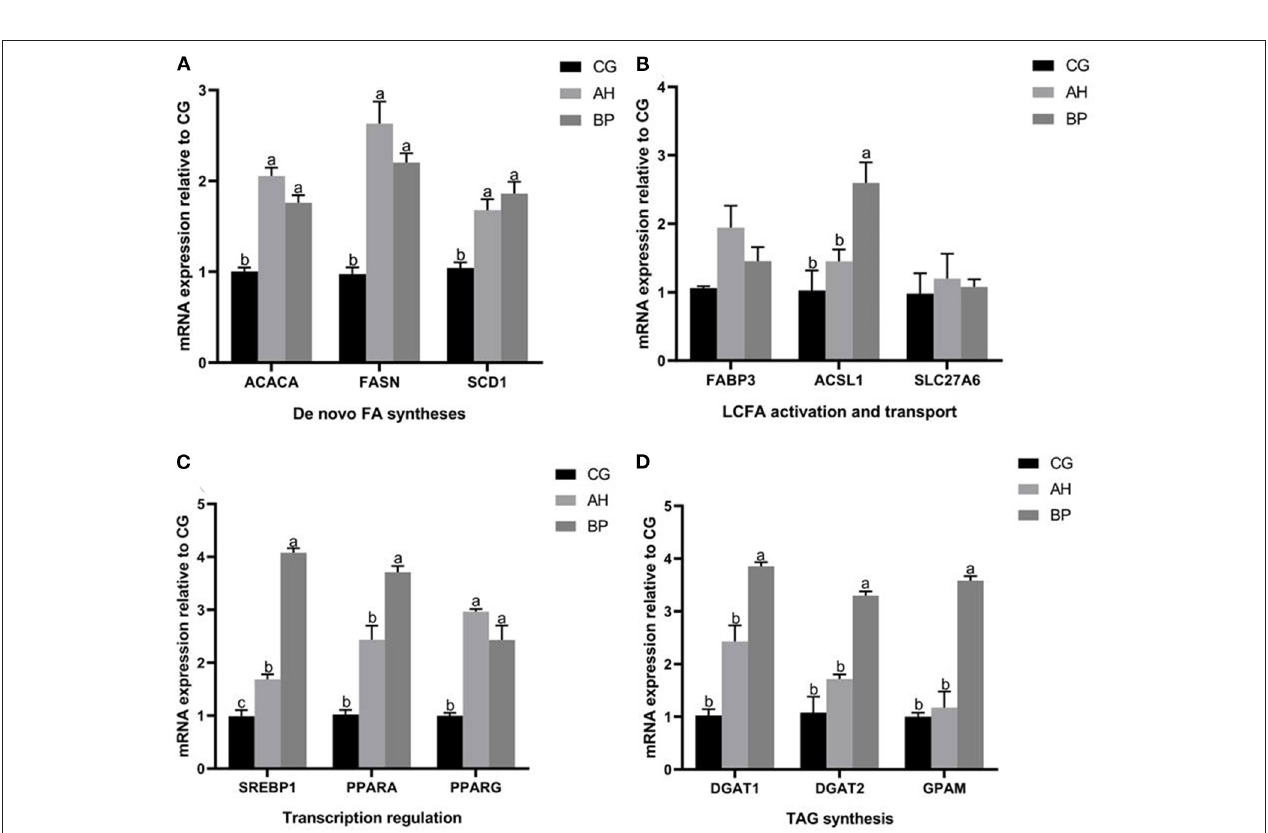
FIGURE 6 | Effect of alfalfa flavone and hybrid Broussonetia papyrifera flavone on the mRNA of fatty acid synthesis related genes in gMECs. (A) De novo FA synthesis; (B) LCFA activation and transport; (C) Transcription regulation; (D) TAG synthesis. Mean values without common superscript (a and b) differ significantly among CG, AH, and BP groups ( p < 0.05). The c value indicates the mRNA level of SREBP in the BP group was significantly higher than that in the CG and AH groups, and the mRNA level of SREBP in the AH group was significantly higher than that in the CG group. of nutrients, leading to an increase in milk production